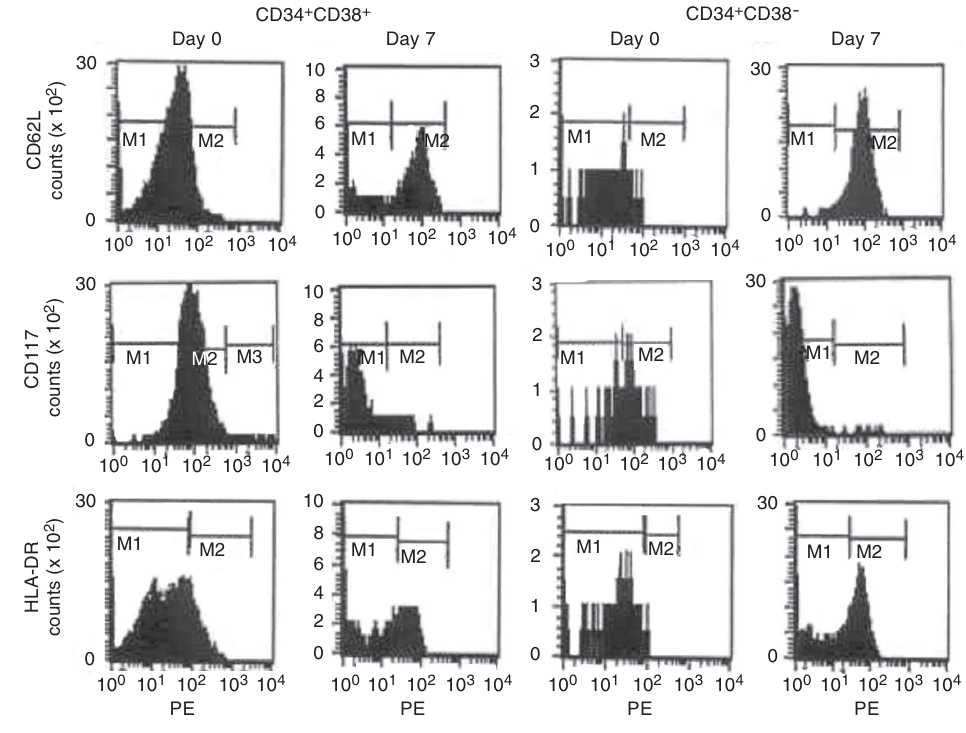
Figure 3. Frequency of cells positive for CD62L/PE, CD117/ PE and HLA-DR/PE among CD34 + CD38 + and CD34 + CD38 - cells on day 0 and after 7 days of culture with TPO + FL + KL. TPO = thrombopoietin; FL = FLT-3 ligand; KL = kit ligand. PE = fluo- rochrome phycoerythrin. M1 = isotype control; M2 = cells with regular fluorescence; M3 = cells with bright